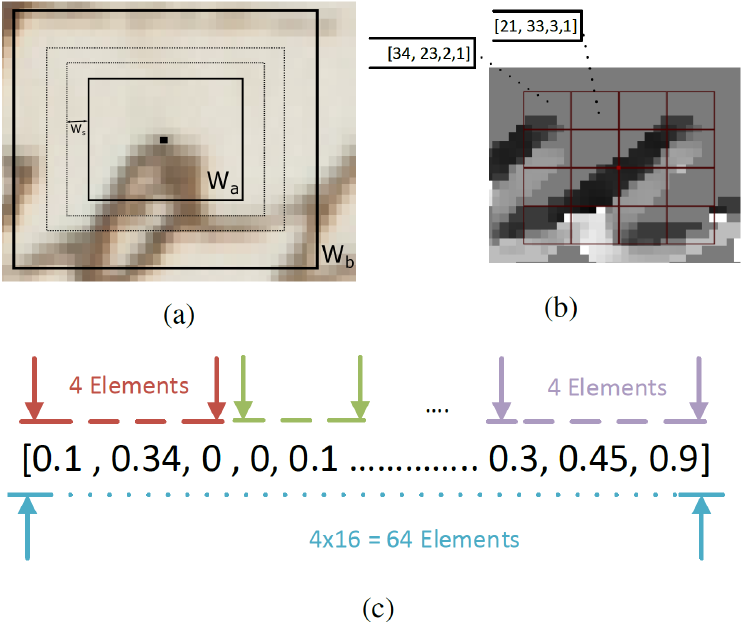
Figure 5. Feature extraction: ( a ) scale invariant window size definition; ( b ) features calculation; ( c ) descriptor